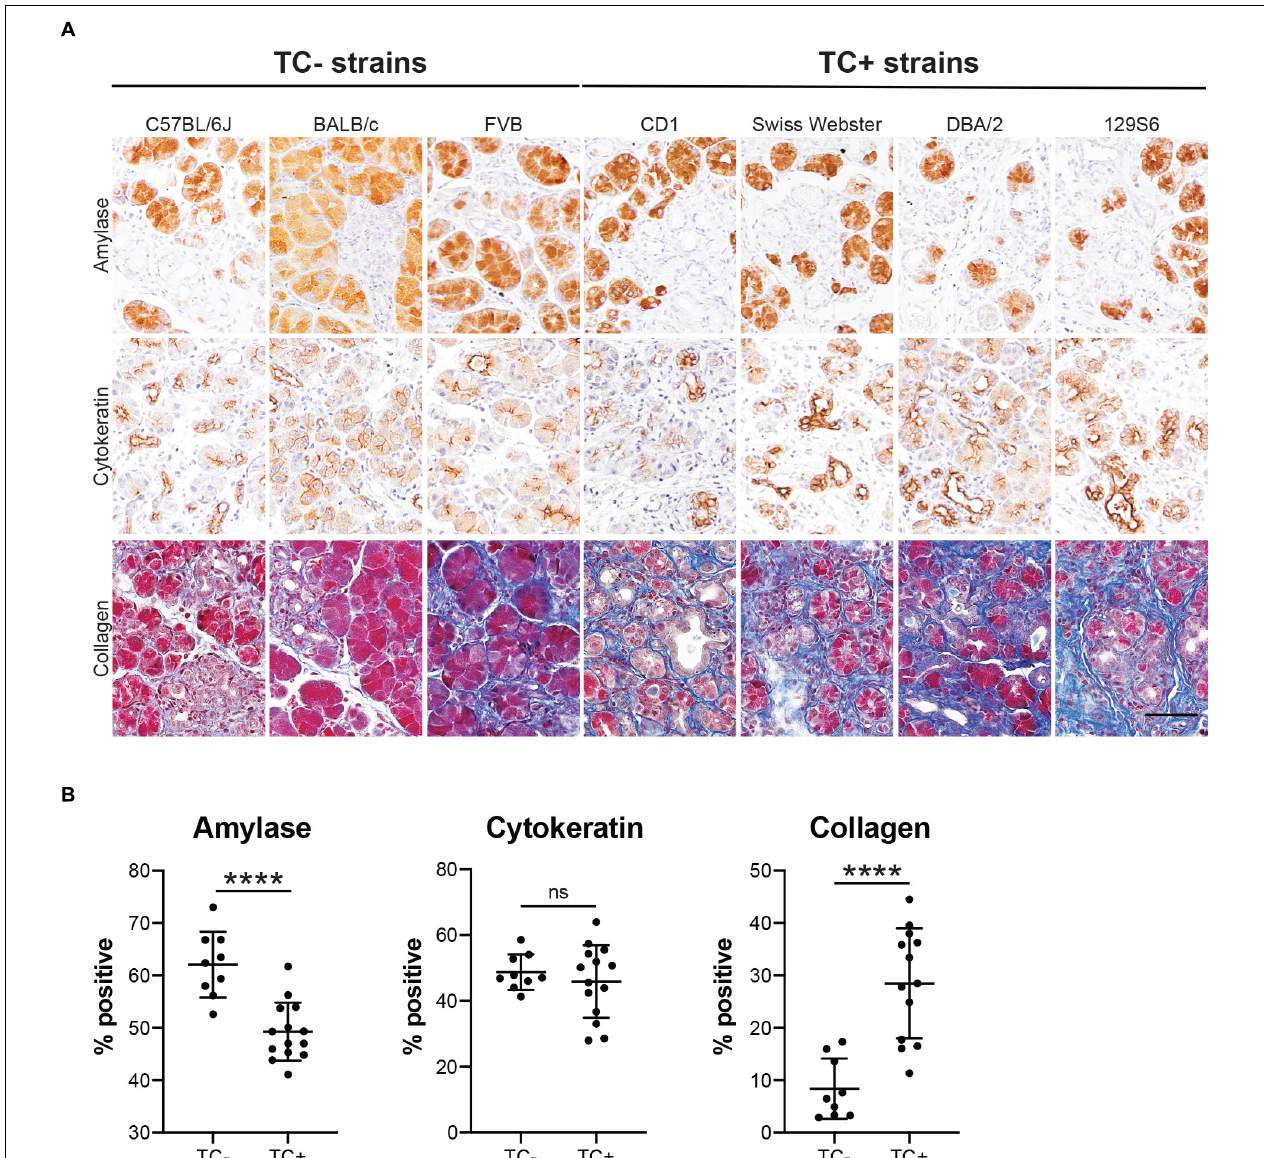
FIGURE 7 | Epithelial and stromal marker expression in caerulein-induced pancreatitis varies by mouse strain. (A) IHC for acinar cell marker amylase or ductal cell marker cytokeratin (both brown), or collagen staining (Trichrome, blue) in the pancreata of mice treated with four cycles of caerulein, quantified in (B) . Scale bar, 50 µ m. TC–, measurements from mouse strains lacking tuft cells (C57BL/6J, BALB/c, and FVB); TC+, measurements from mouse strains that form tuft cells in response to caerulein (CD1, Swiss Webster, DBA/2, 129S6). **** p < 0.01; ns, not significant.